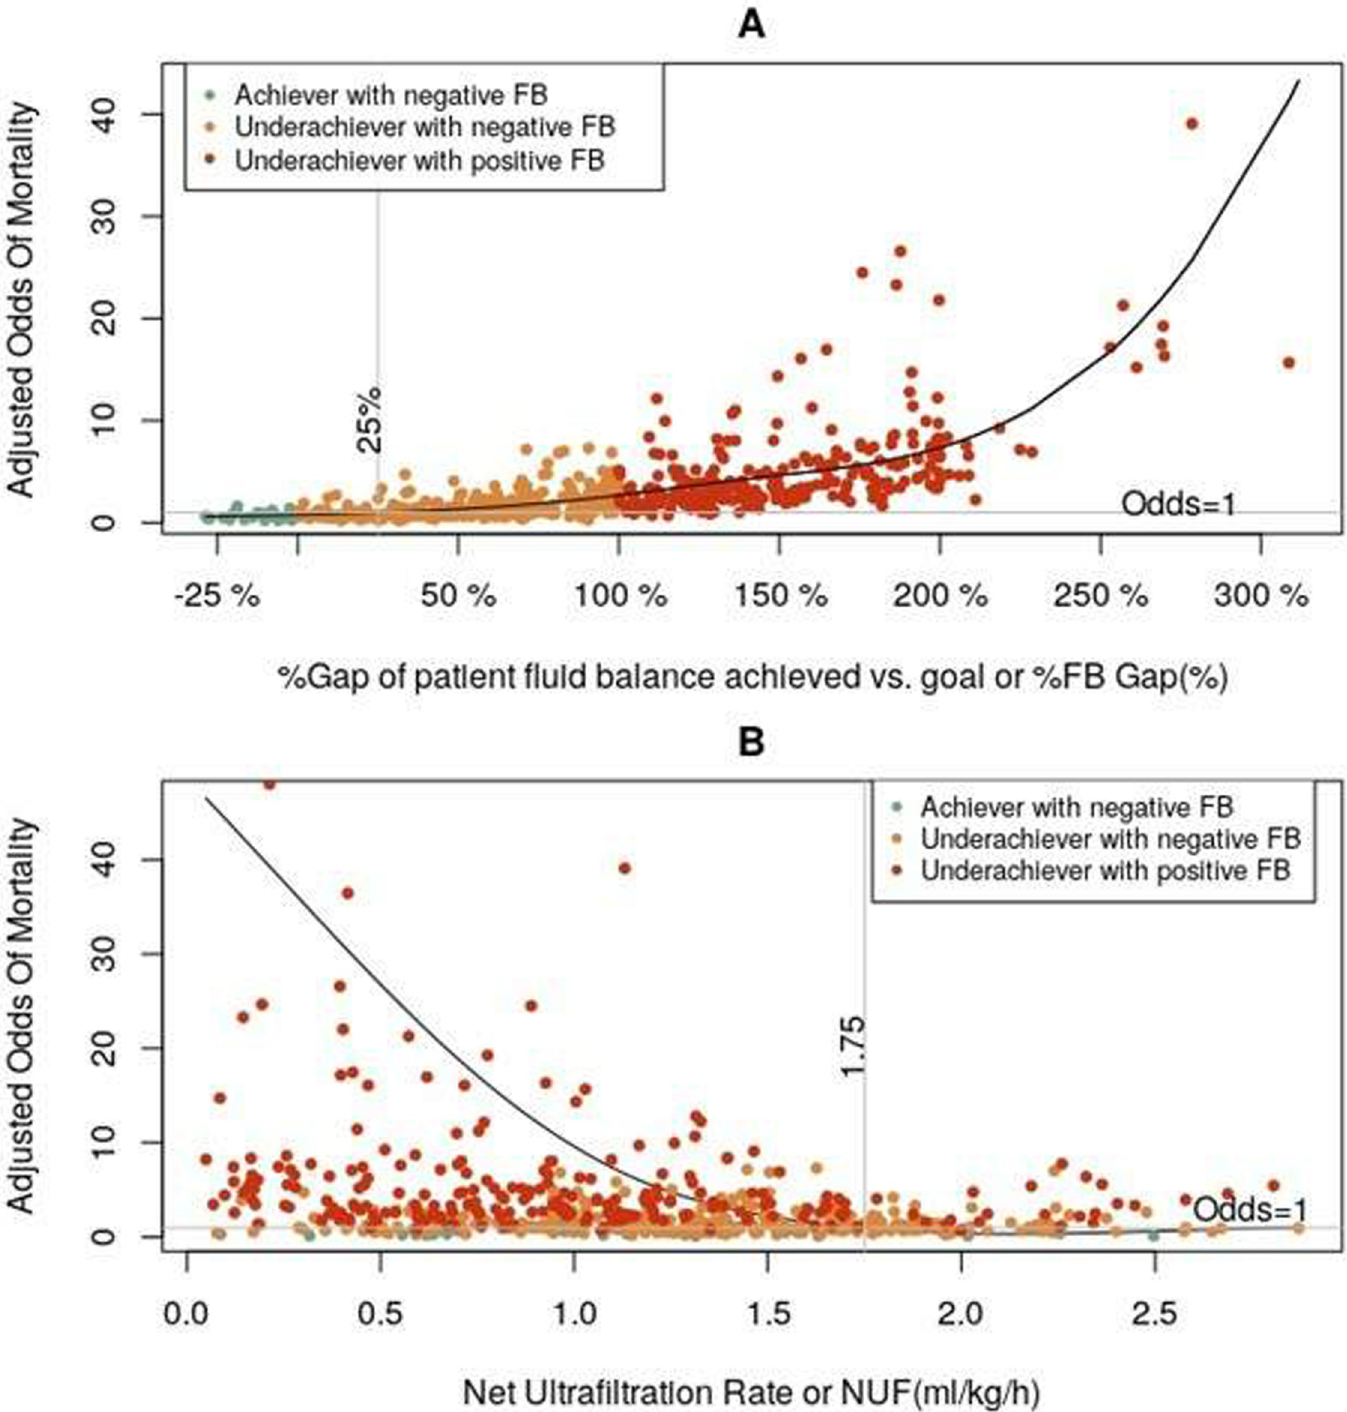
Fig 5. Restricted cubic splines representing the adjusted relationship of A) %FB Gap and B) NUF (ml/kg/h) with hospital mortality according to final multivariable models. Note that %FB Gap better differentiate the 3 clinical subgroups than NUF for the association with mortality.